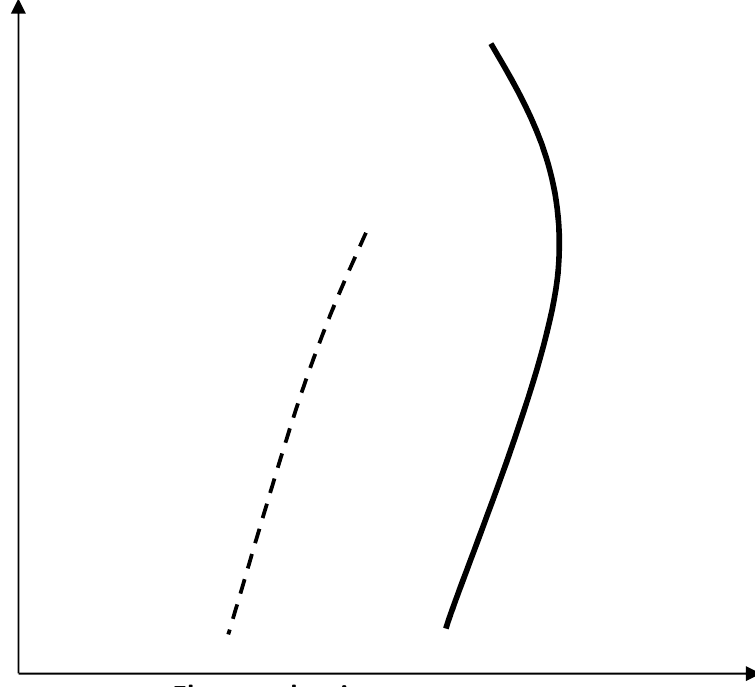
Figure 7. Schematic diagram showing the dependence of the macrosegregation of element X (vertical axis) on alloying elements in specific phases in Nb silicide-based alloys. The ranges of X values are given in Table 6 and 7. The chemical analysis data for specific phases in Nb silicide-based alloys can be found in the references given in the tables 6 to 9. The thick line shows (a) how the Si macrosegregation varies with ([Si + Ge]/Cr) Laves (range 2.3 to 4.4, nose ZF6), (TM/[Si + Ge]) Nbss (range 6.8 to 18.9, nose ZF9), (Ti/Cr) Nb5Si3 (range 12.7 to 17.5, nose ZF9), (Ti/Cr) Ti rich Nb5Si3 (range 9.8 to 30, nose ZF9), (TM/SM) Nb5Si3 (range 0.5 to 0.8, nose ZF9), (TM/SM) Ti rich Nb5Si3 (range 0.6 to 1, nose ZF9) and